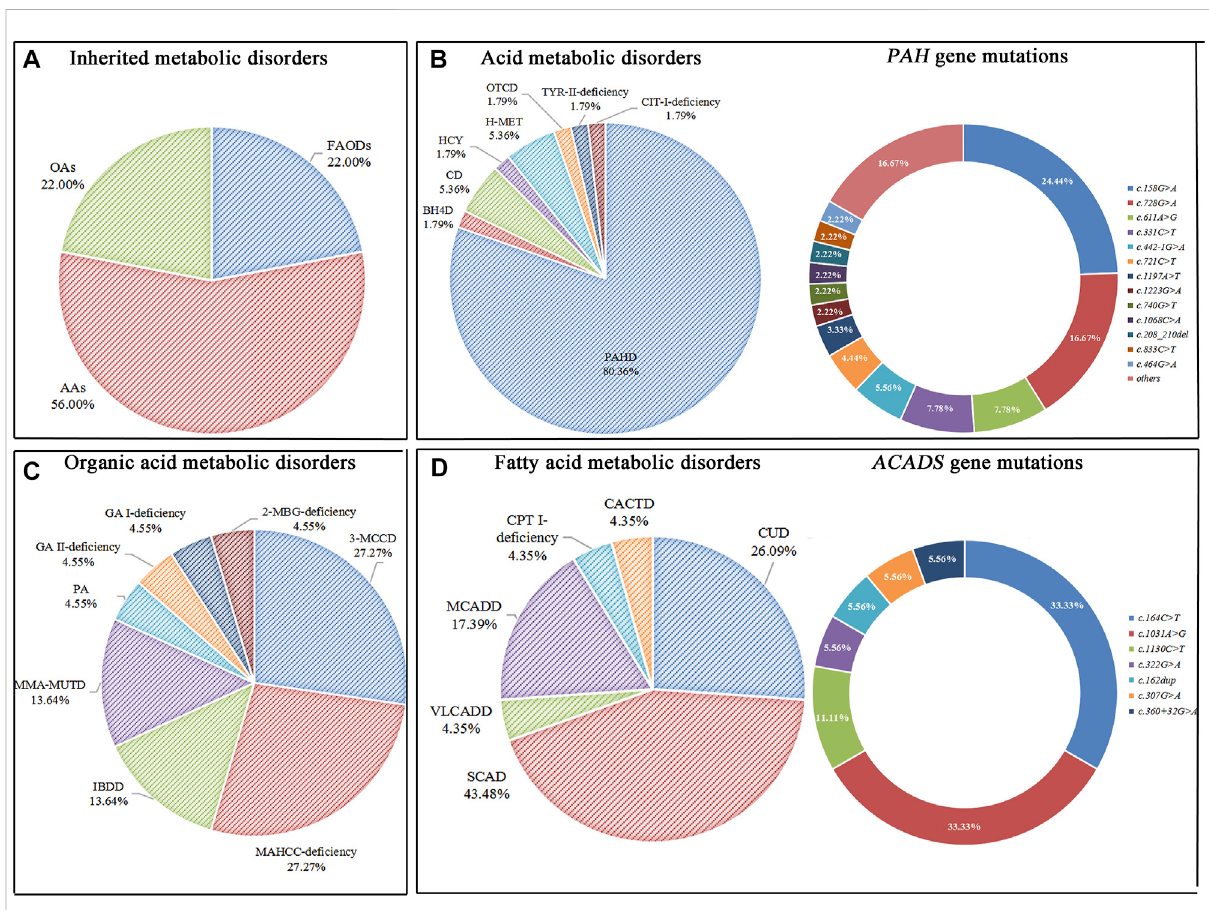
FIGURE 2 Disease spectrum, distribution, and gene mutations of inherited metabolic disorders. (A) The percentage of three categories of inherited metabolic disorders. (B) The percentage of different types of amino acid metabolic disorders and alleles of PAH gene mutations. (C) The percentage of different types of organic acid metabolic disorders. (D) The percentage of different types of fatty acid metabolic disorders and alleles of ACADS gene